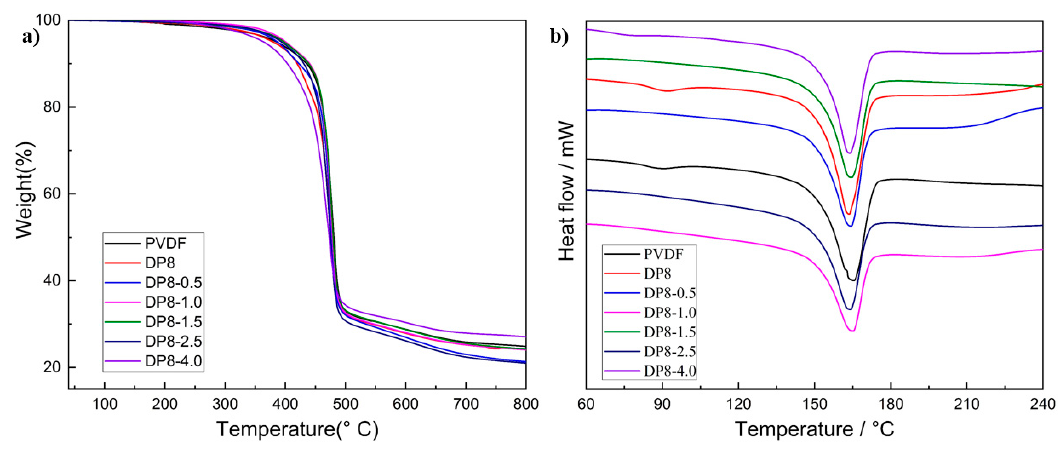
Figure 3. ( a ) TGA and ( b ) DSC curves of pure PVDF nanofiber membrane and DP8–X fiber membranes.